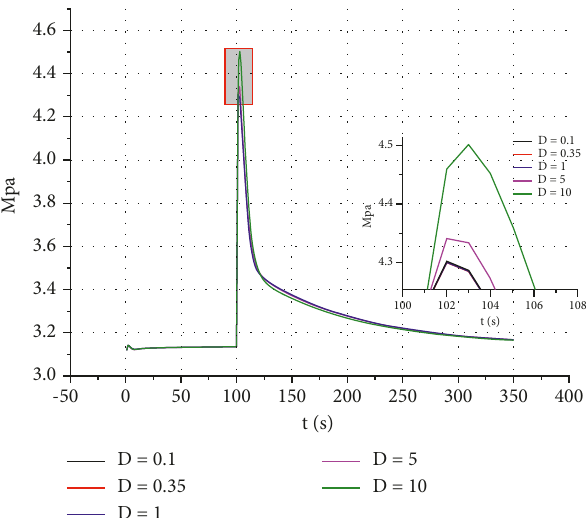
Figure 6: The changes of pressure at different D when P and I are